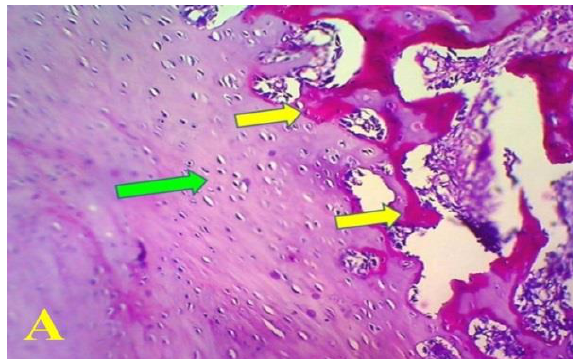
Figure, 4: In the first group at the tenth week, shown proliferation of fibrocartilaginous tissue in quantities exceeding the fibrous tissue (green arrow) with ossification of some chondrocytes (yellow arrow). A: H&E X40, B: Masson trichrom X40 In the second group, the histopathological examination showed a significant proliferation of fibrocartilaginous tissue with ossifications of some chondrocytes rather than formation of new trabecular bone in many fractured areas, (Fig. 5: A and B).